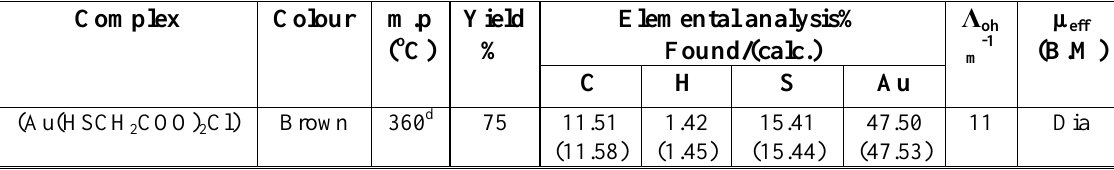
Table( 2 ): Electronic and Infrared Specification of the complex UV.